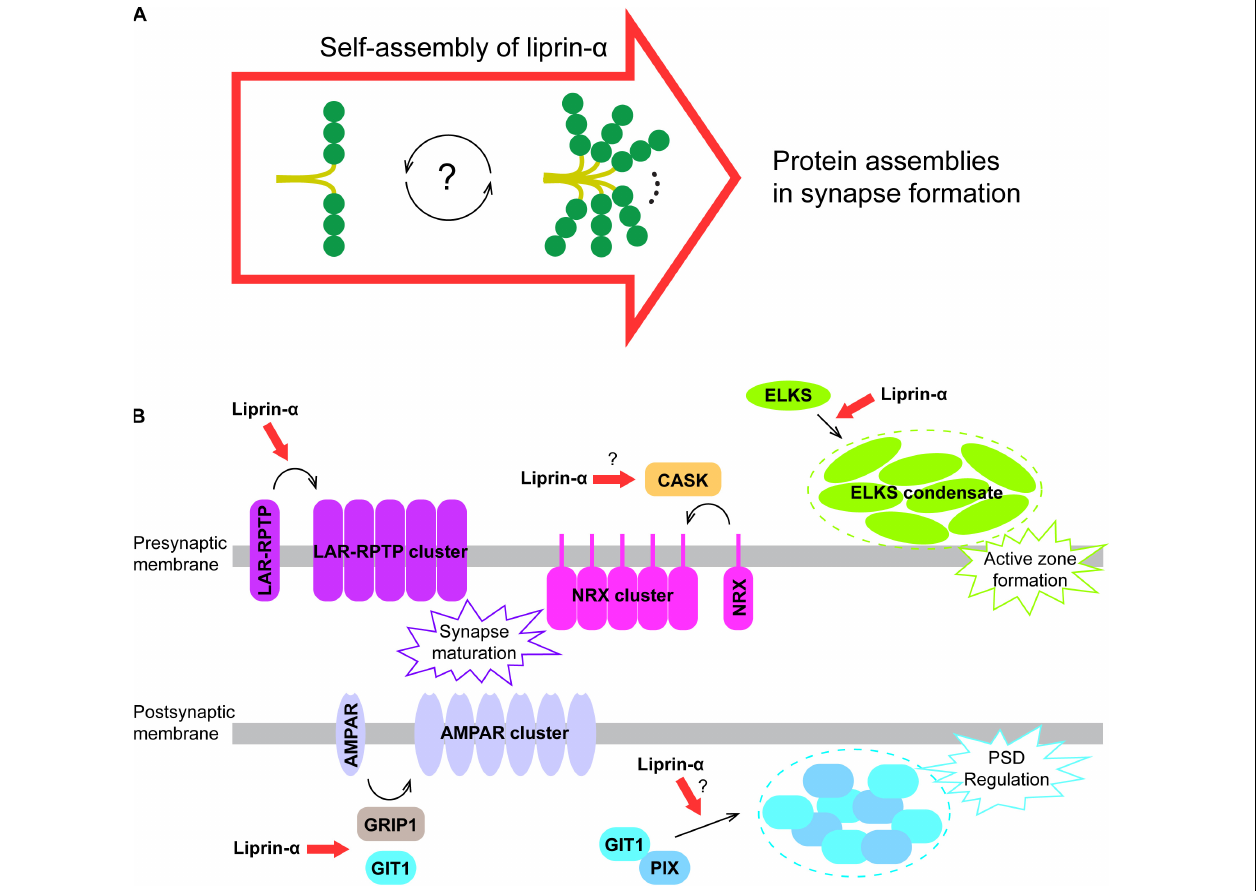
FIGURE 5 | A proposed model for liprin- α assembly in mediating protein accumulation in synapse development. (A) Liprin- α is self-assembled to form a large complex and to mediate protein assemblies. (B) The highly self-assembled liprin- α proteins, indicated by red arrows, organize different receptor clustering and protein condensates (indicated by dotted circles) on both presynaptic and postsynaptic membrane in synapse formation, although no direct evidence showing the involvement of liprin- α in the clustering of Neurexin and the condensation of the GIT1/PIX